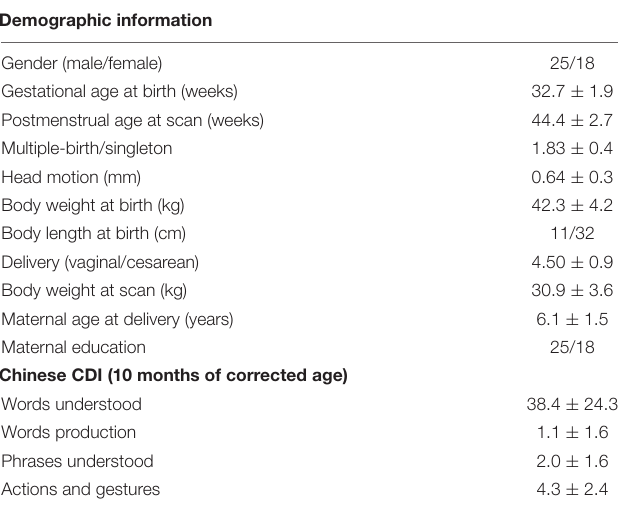
TABLE 1 | Demographic information of the infants and their communication development of infant (CDI) sub-scores at 10 months. Demographic information